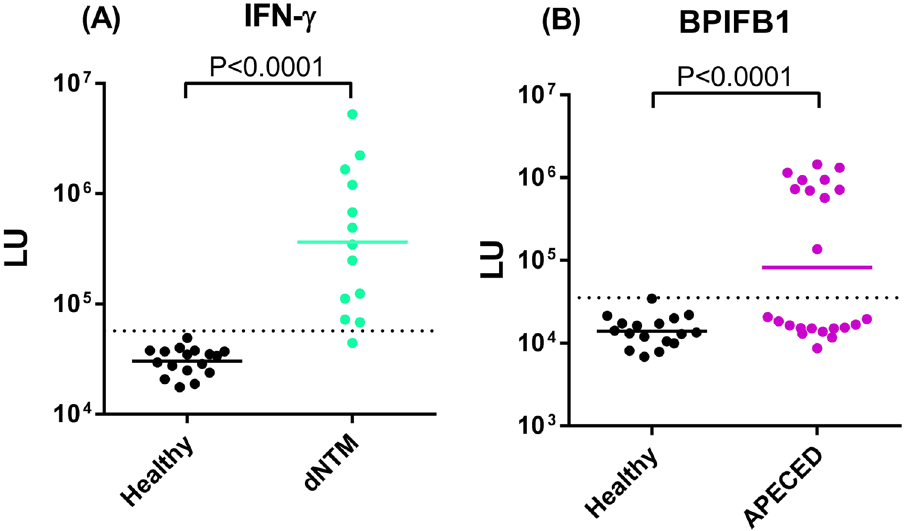
Figure 5. LIPSTICKS autoantibody detection for autoimmune disease diagnosis. ( A ) LIPSTICKS detection of serum autoantibodies against IFN- γ in a cohort of disease controls (black) and subjects with disseminated non- tuberculosis infection (eucalyptus green) demonstrated a diagnostic performance of 95% sensitivity and 100% specificity. ( B ) Autoantibodies against BPIFB1 in the sera of control subjects (black) and subjects with APECED (purple) were measured by LIPSTICKS. Only a subset of APECED patients had known BPIFB1 autoantibodies and comparison revealed that LIPSTICKS had a diagnostic performance of 95% sensitivity and 100%